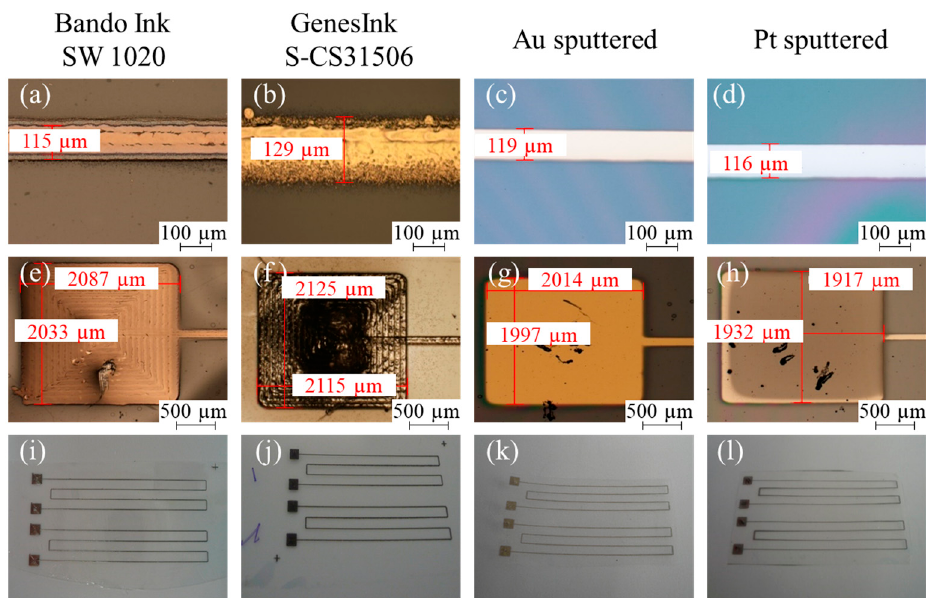
Figure 5. Representative front side light microscopic images of obtained lines ( a – d ) and pads ( e – h ) before the transfer, as well as photos of transfer results ( i – l ) for the different materials and deposition technologies, respectively. Table 2. Obtained dimensions, electrical conductivities before and after the transfer process, as well as transfer results for the different metals and deposition technologies. The values represent aver- aged results over three measurements each. The error given for the dimensions relates to the stand- ard deviation.